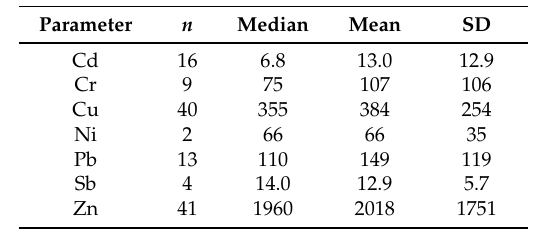
Table 5. Median annual runoff loads (g/ha) for all traffic areas. For Pb, only data measured in the 21st century was used.